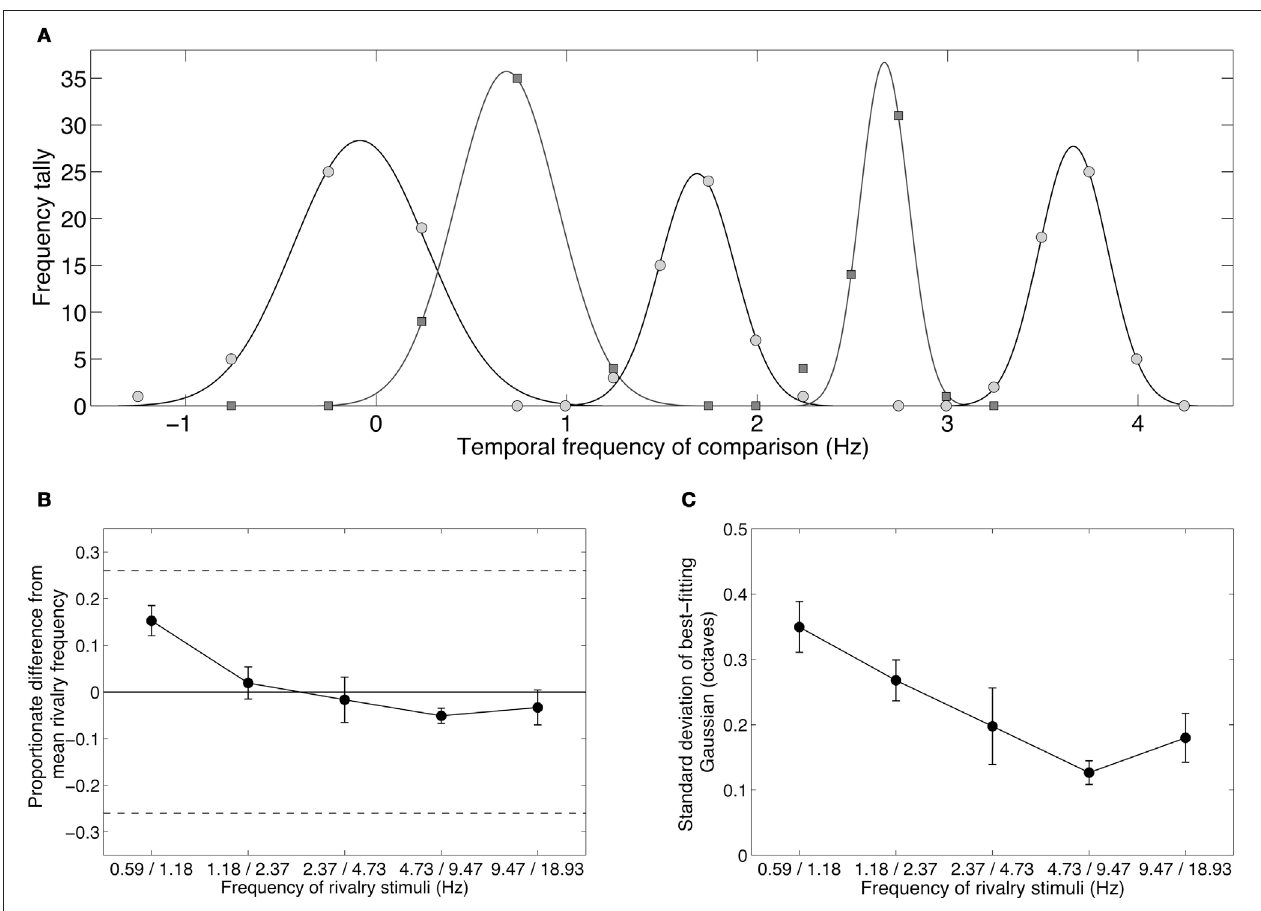
FIGURE 5 | Results from Experiment 2B showing the temporal frequency perceived during binocular rivalry between stimuli differing by one octave. Observers chose their matches from a range of nine temporally modulating stimuli (see Table 2 ). (A) Data from one observer showing distributions of temporal frequency matches for each of the one-octave pairs shown in Table 1 . The data were well described by Gaussian distributions. Note that the frequencies were converted to a log 2 scale (i.e., an octave scale) before fitting the Gaussian. (B) Group mean data plotting the means of the Gaussian distributions with respect to the